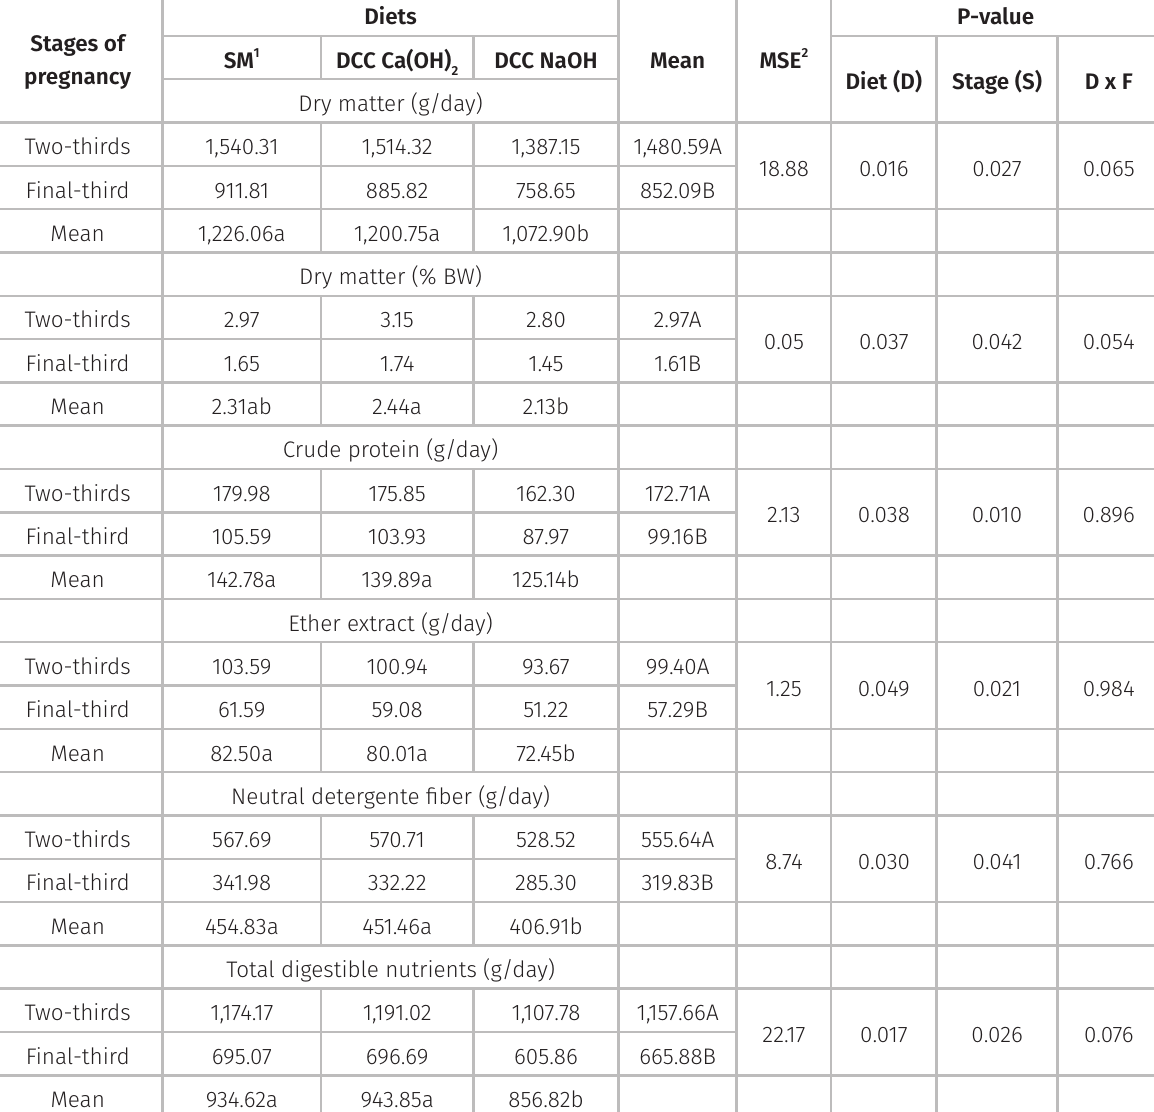
Table III. Dry matter intake and nutrients of goats fed with detoxified castor cake (DCC) at different stages of